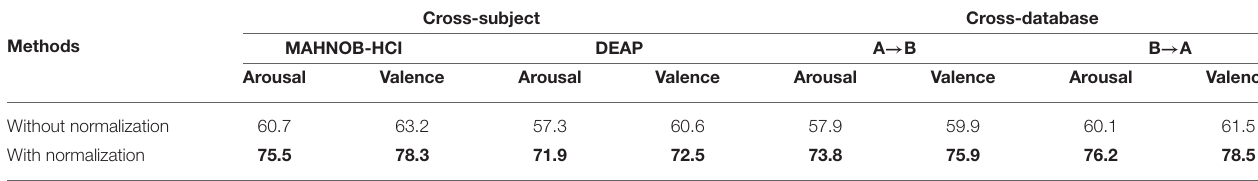
The bold values indicated the highest accuracy